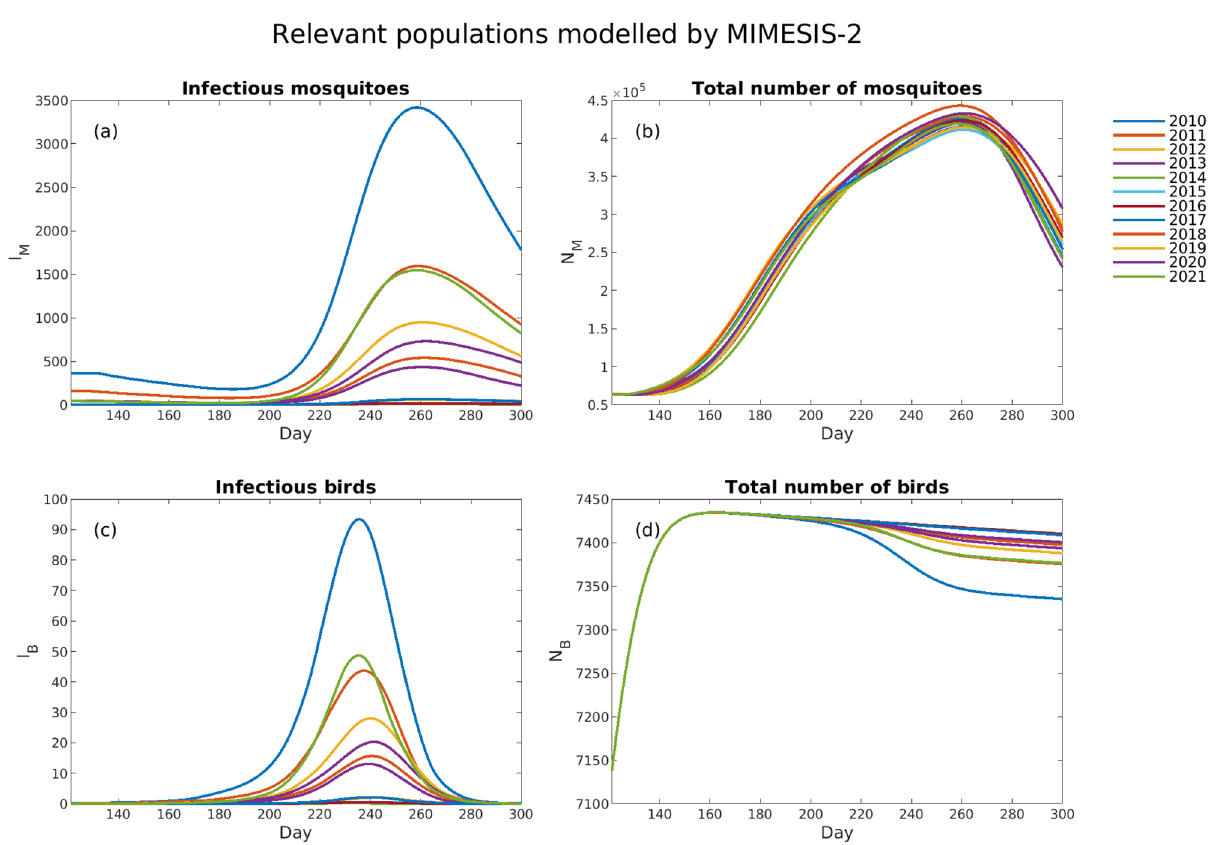
Figure 5. The temporal evolution during May to October of ( a ) the number of infected mosquitoes modelled by MIMESIS-2 ( I M ), ( b ) the total number of mosquitoes modelled by MIMESIS-2 ( N M ) , ( c ) the number of infected birds modelled by MIMESIS-2 ( I B ) , and ( d ) the total number of birds modelled by MIMESIS-2 ( N B